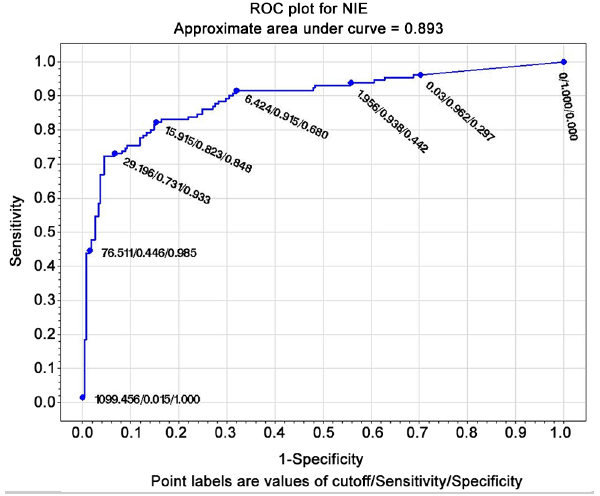
Figure 5. ROC curve for NIE-ELISA (composite reference standard).